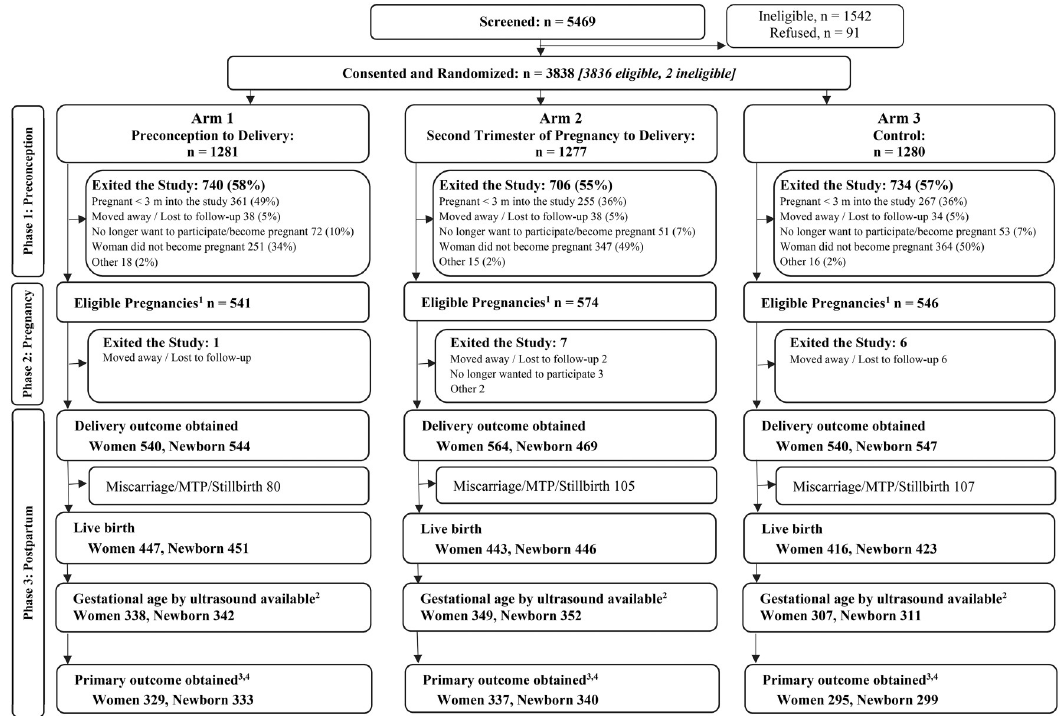
Fig 1. Consort Diagram for Women First Preconception Maternal Nutrition Trial in South Asian region. 1 Excludes women who became pregnant < 3 months into the study. The women who had eligible pregnancies may have had delivery data obtained or they may have exited the study prior to delivery. 2 Gestational age (GA) at birth is defined as the age at the time of the ultrasound based on the ultrasound plus time until birth if the ultrasound was done between 6 weeks + 0 days to 13 weeks + 6 days and the GA at birth is between 24 weeks + 0 days and 42 weeks + 6 days. 3 Primary outcome was obtained for live newborns with three length measurements taken within 48 hours of delivery. 4 Length-for-age, weight-for-age, head circumference-for-age, and weight-length- ratio-for age Z-scores and percentiles based on measurements within 48 hours of age are calculated using the INTERGROWTH-21st International Standards for Newborn Size [37] and International Standards for Newborn Size for Very Preterm Infants [38] which provide Z-scores by sex and GA at birth for infants born between 33 weeks + 0 days to 42 weeks + 6 days GA at birth and between 24 weeks + 0 days to 32 weeks + 6 days GA at birth, respectively.